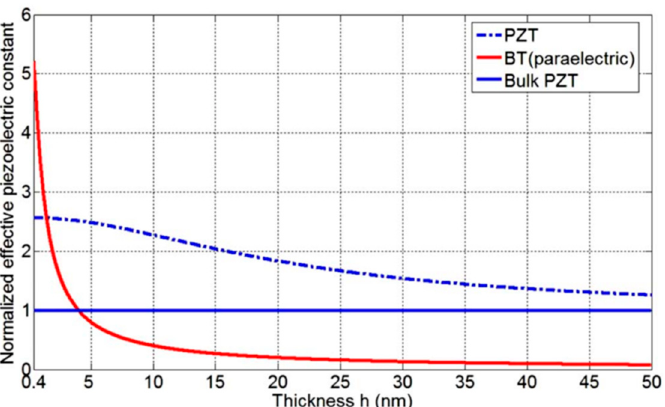
Figure 15. Effective piezoelectric constant of PZT (dashed blue line) and BT (solid red line) cantilevers. The piezoelectric constants of the two cantilevers are normalized with respect to the bulk PZT value (solid blue line). Reprinted with permission from [95]. Copyright 2008, American Physical Society)